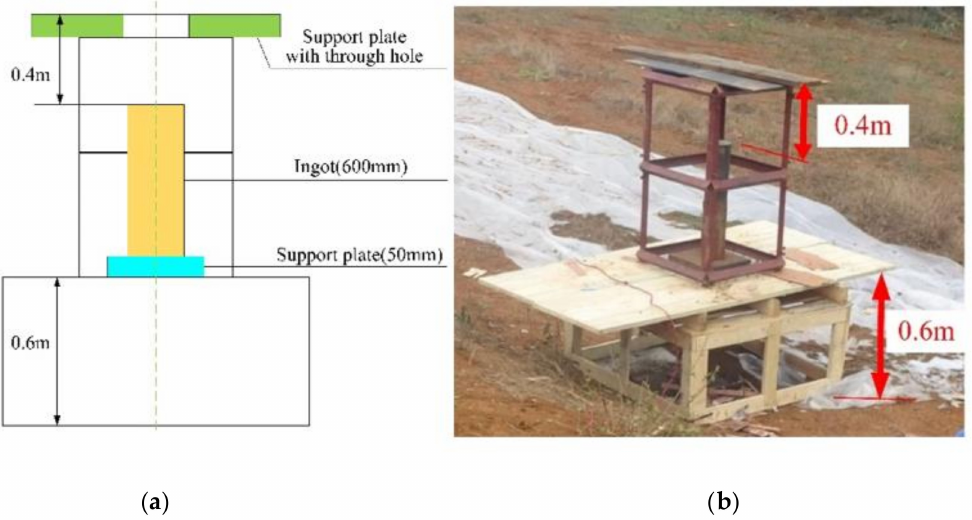
Figure 10. Layout of the test device. ( a ) The schematic diagram of the experimental device; ( b ) Layout of test target frame.